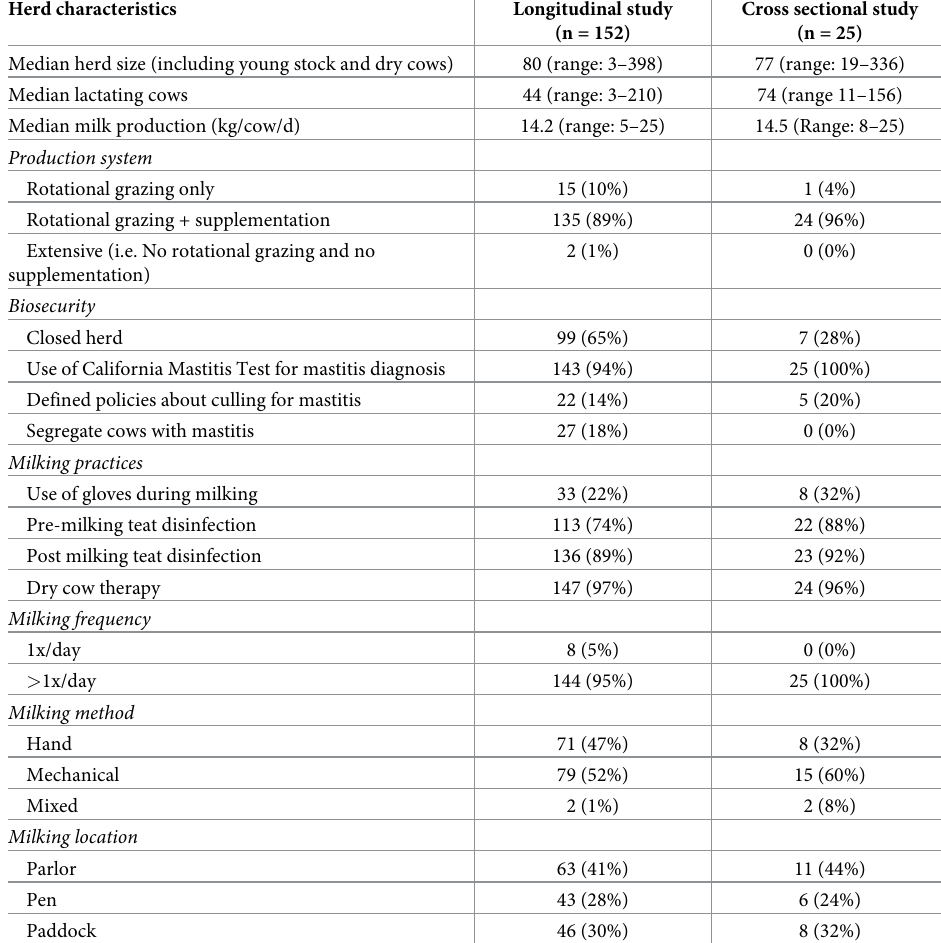
cus agalactiae in bulk tank milk, and 25 herds participating in a cross-sectional study in central western Colombia. Herd characteristics Longitudinal study